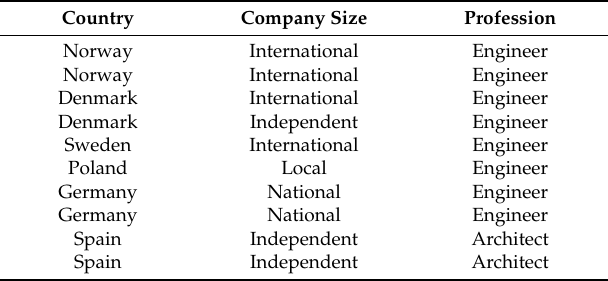
Table 1. Information of companies and